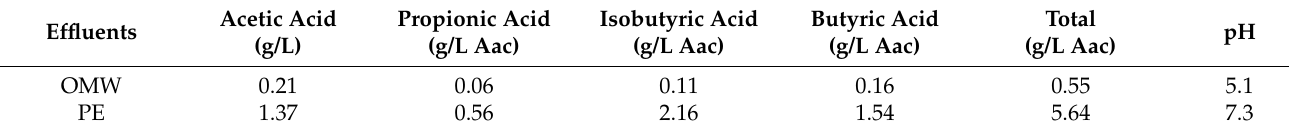
Table 3. Effluents: Volatile fatty acids and pH.